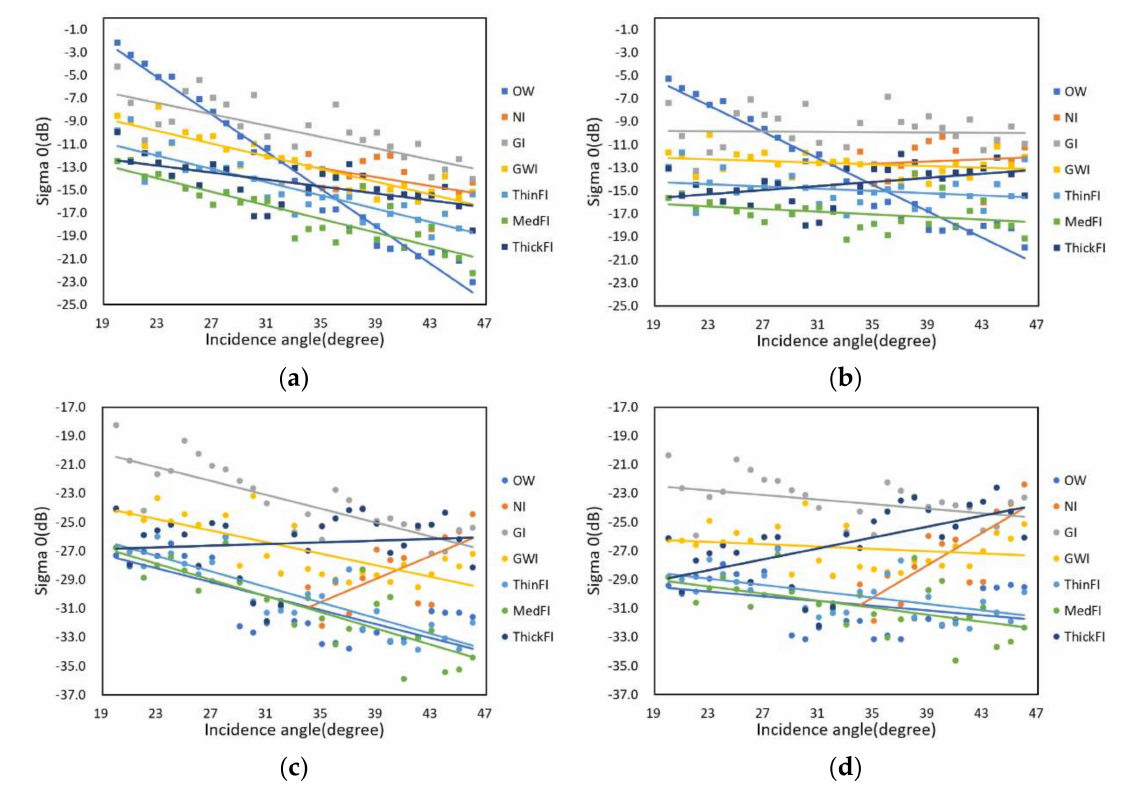
Figure 5. The dependence of the backscattering coefficient on incidence angle. Before ( a ) and after ( b ) coarse correction of HH-polarization incidence angle dependence. Before ( c ) and after ( d ) coarse correction of HV-polarization incidence angle